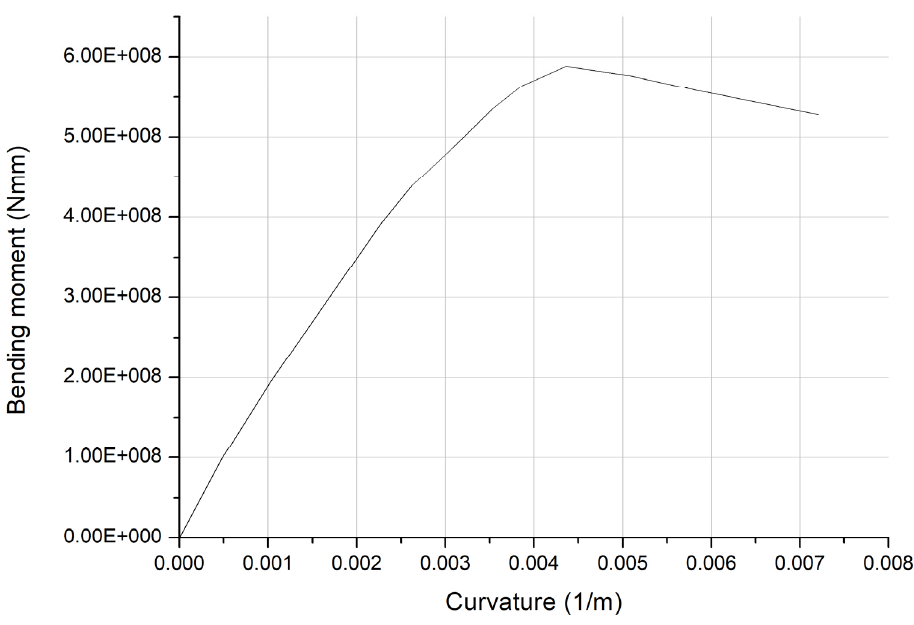
Figure 2. Load and curvature curve of box girder MST-3 under static bending moment in the experiment [23].